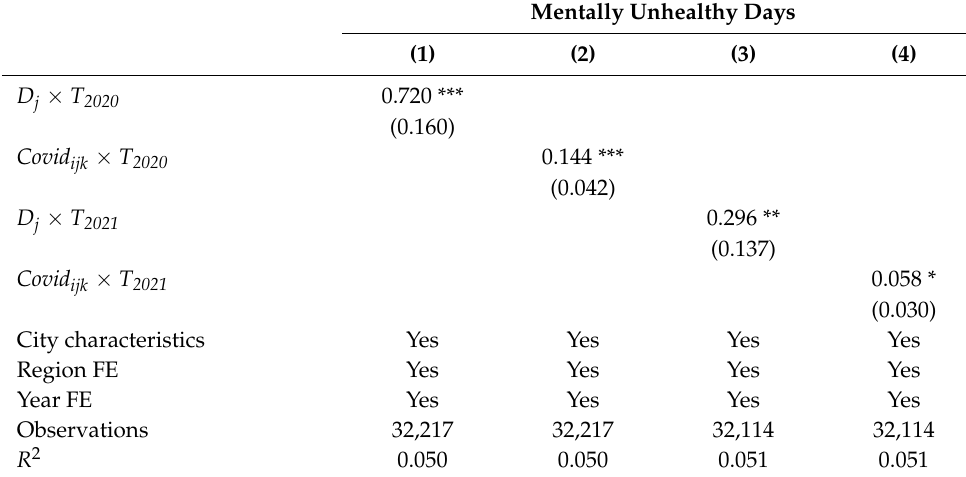
Table 6. DID regression.